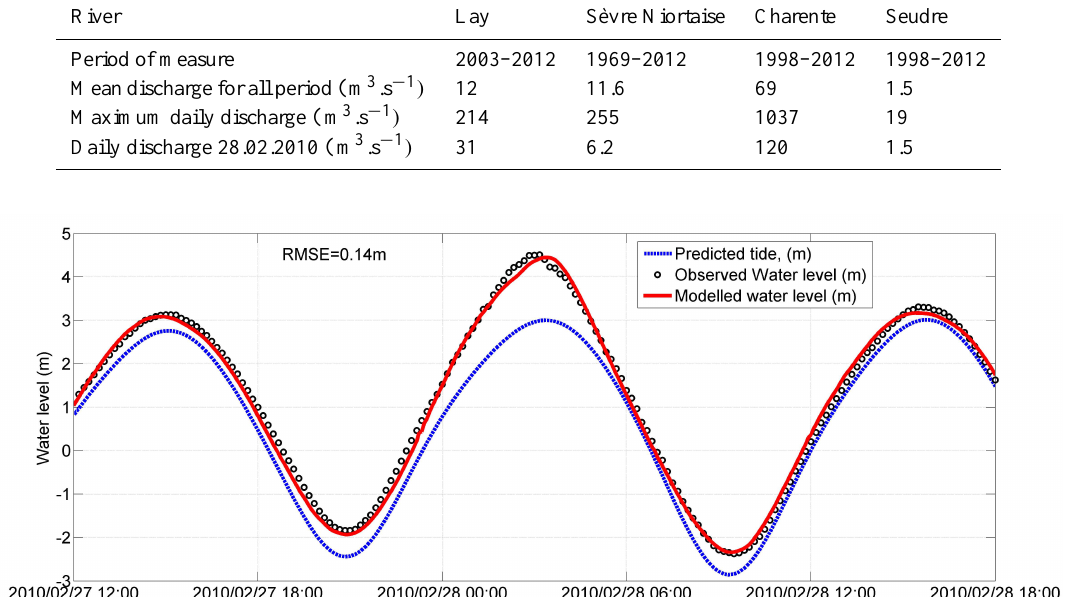
Fig. 2. Predicted tide (blue line), observed water level at the La Pallice tide gauge (black circles) and modeled water level from Bertin et al. (2012a) storm surge modeling system (red line), in meter NGF, during the Xynthia